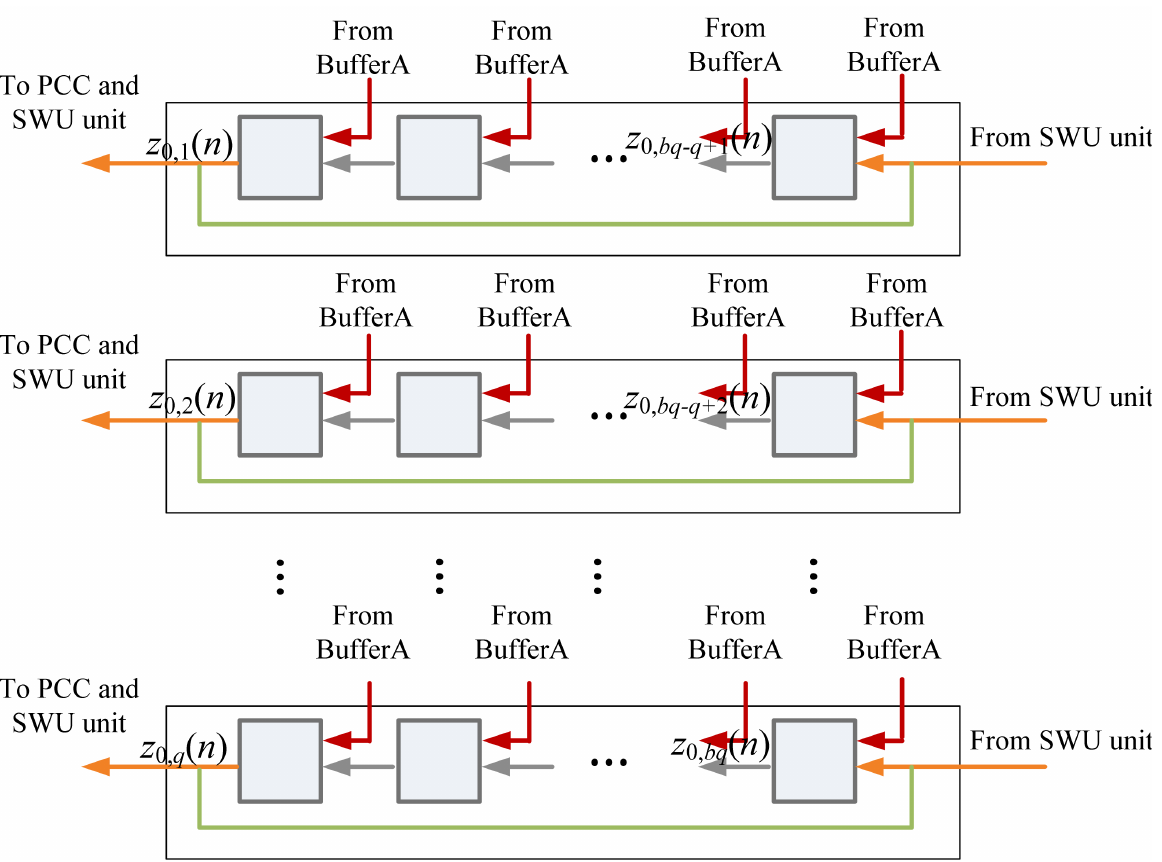
Figure 8. The Buffer B architecture in memory